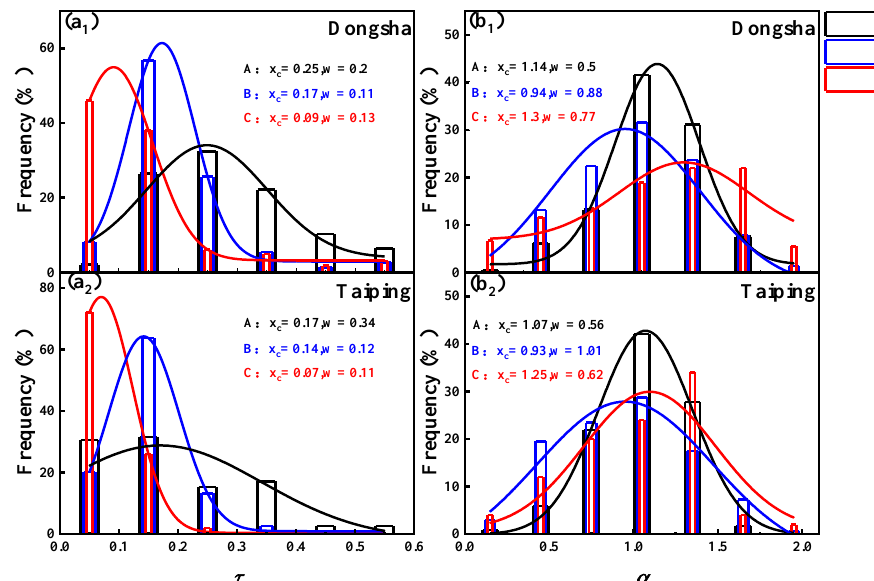
Figure 9. Distribution of the frequency of occurrences of ( a 1 , a 2 ) τ , and ( b 1 , b 2 ) α in three sectors: A, B, C. These data are shown in black (sector A), blue (sector B) and red (sector C). The distribution of different sectors (colored lines) was identified by Gaussian fitting (fitted line, y = y0 + (A/(w*sqrt(pi/2)))*exp( − 2*((x − xc)/w)^2)). The center value (xc) and waist width (w) of each part of the Gaussian function are shown.